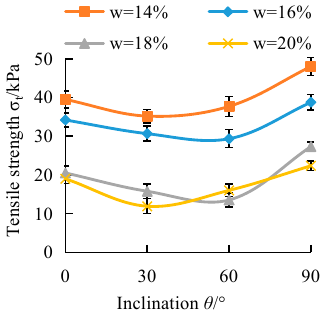
Figure 8. Tensile strength in different directions ( ρ d = 1.48 g/cm 3 ).